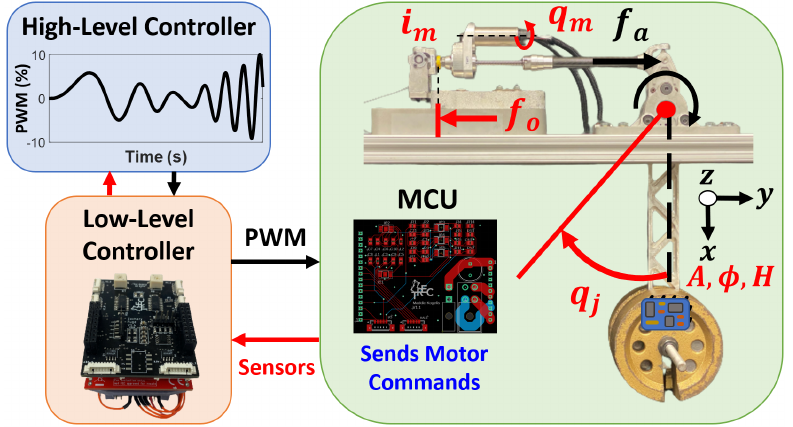
Figure 13. The pendulum test bed has a single LSEA actuator driving a 10 kg mass at the end of a 0.3 m long lever arm with all sensor feedback